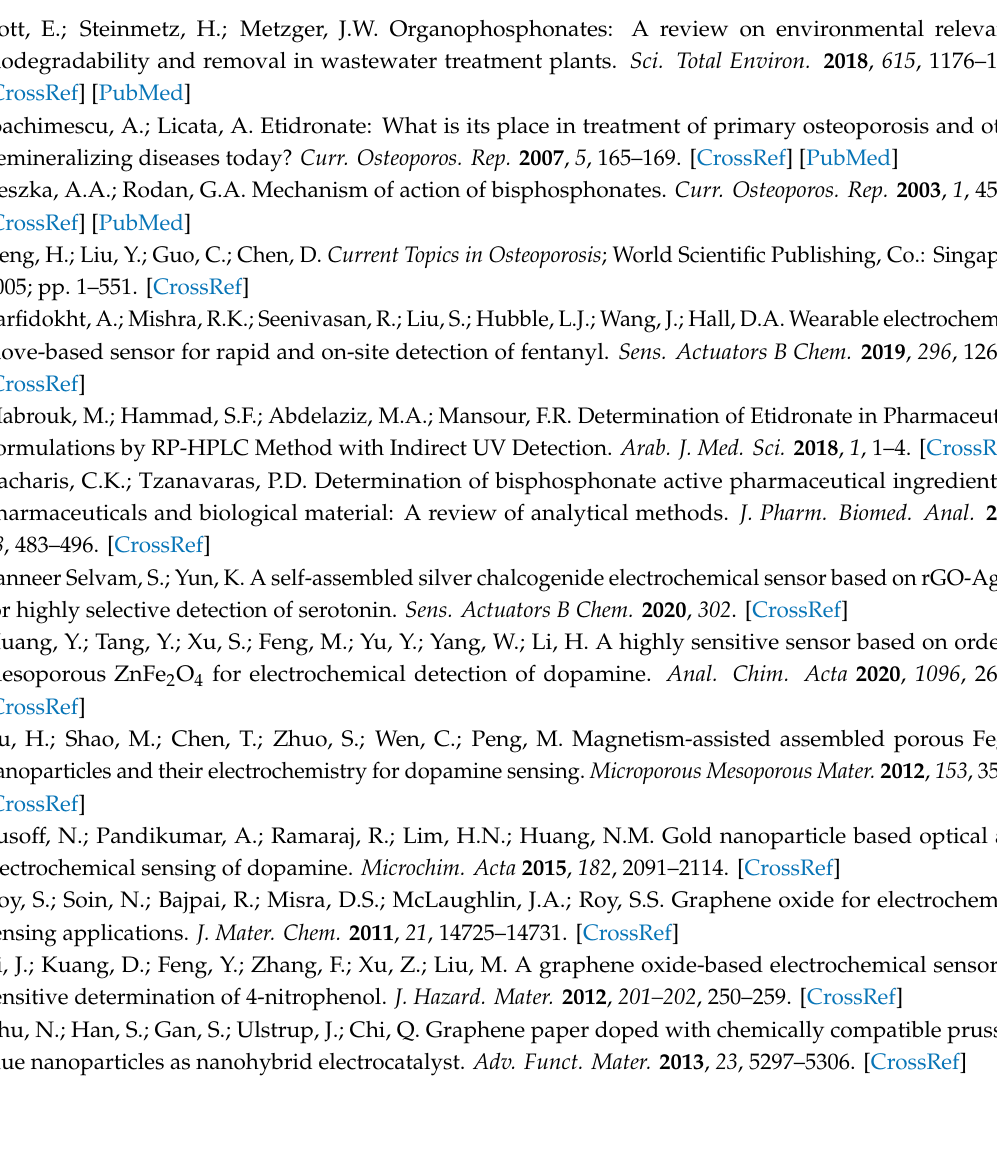
Figure 7. ( a ) Effect of the scan rate (25–200 mV/s) on the rGO-Ag@SiO 2 /Au PCB in the presence of 1 Figure S1: Photographs of Au PCB; Figure S2: (a), (b), and (c) EDX spectra of bare Au PCB, rGO / Au PCB, mM etidronic acid (EA) in a 0.1 M NaOH electrolyte (pH = 13). ( b ) Linear relationship between the and rGO-Ag@SiO 2 / Au PCB, respectively; Figure S3: (a), (b) CV responses of non-faradaic current response of square root of the scan rate ( ʋ 1/2 ) and the oxidation peak current ( I pa ) for EA. ( c ) Differential pulse bare Au PCB and rGO-Ag@SiO 2 / Au PCB, respectively, in 0.1 M KCl, (c) relationship between scan rate ( voltammetric (DPV) response of 1 mM EA in different pH media [0.1 M acetate buffer (pH = 4.4), 10 mM PBS (pH = 7.4) and 0.1 M NaOH (pH = 13)]. and at a fixed concentration of Ag@SiO 2 (1 mg) in the presence of EA in 0.1 M NaOH. (b) The plot of CrGO / CrGO + CAg@SiO PCB; Figure S7: Raman spectral analysis of graphite, GO, and rGO. Table S1: Comparison of previously reported materials in the detection of EA to the current study; Table S2: ECASA calculation; Table S3. Real-time analysis of EA in the pharmaceutical samples; Table S4. Raman spectral analysis of graphite, GO, and